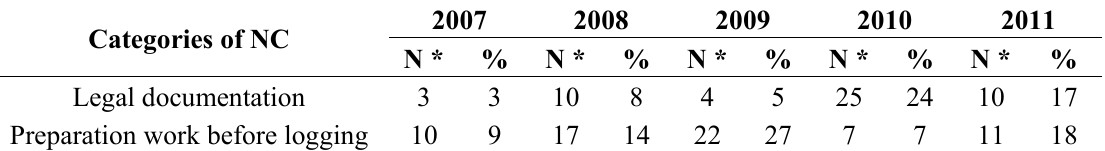
Table 7. Nonconformities detected during the field